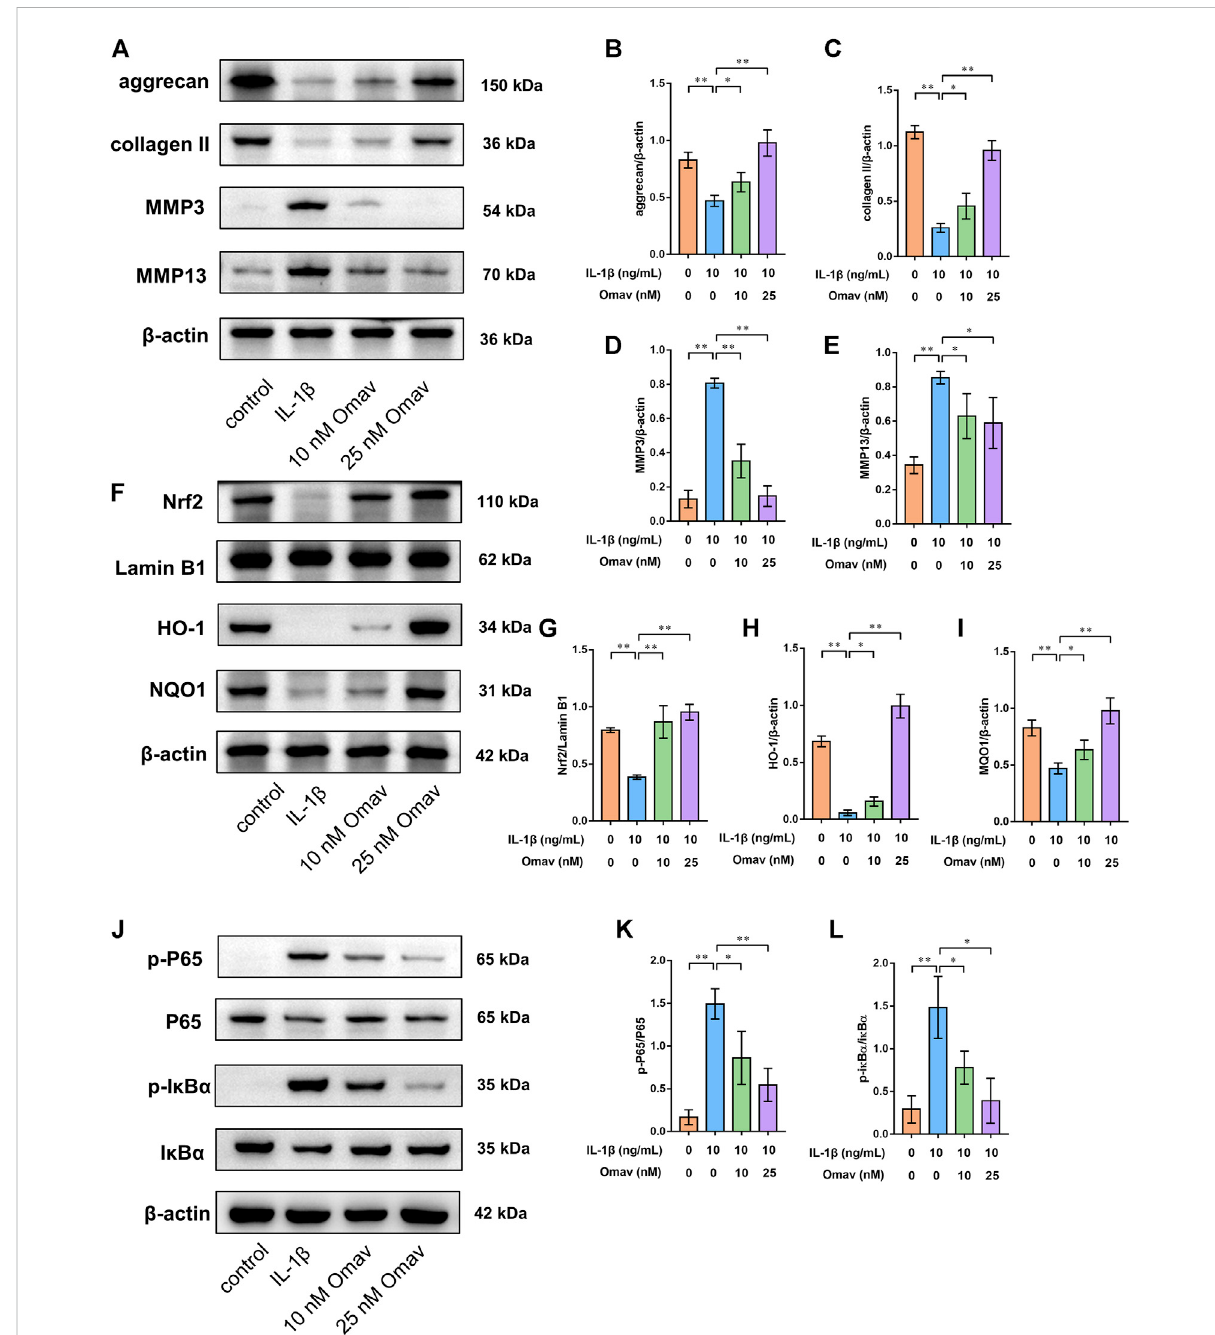
Omaveloxolone activated the Nrf2/ARE signalling pathway while suppressing the NF- κ B signalling pathway in chondrocytes exposed to IL-1 β . (A) Representative Western blots of proteins involved in ECM degradation. Quantitative analysis of aggrecan (B) , collagen type II (C) , MMP3 (D) and MMP13 (E) wasperformed. (F) RepresentativeWesternblotsofproteinsinvolvedintheNrf2/AREsignallingpathway.QuantitativeanalysisofNrf2 (G) , HO-1 (H) and NQO1 (I) was performed. (J) Representative Western blots of proteins involved in the NF- κ B signalling pathway. Omaveloxolone (10 and 25 nM) reduced the p-P65/P65 ratio (K) and p-I κ B α /I κ B α ratio (L) . * p < 0.05 and ** p <